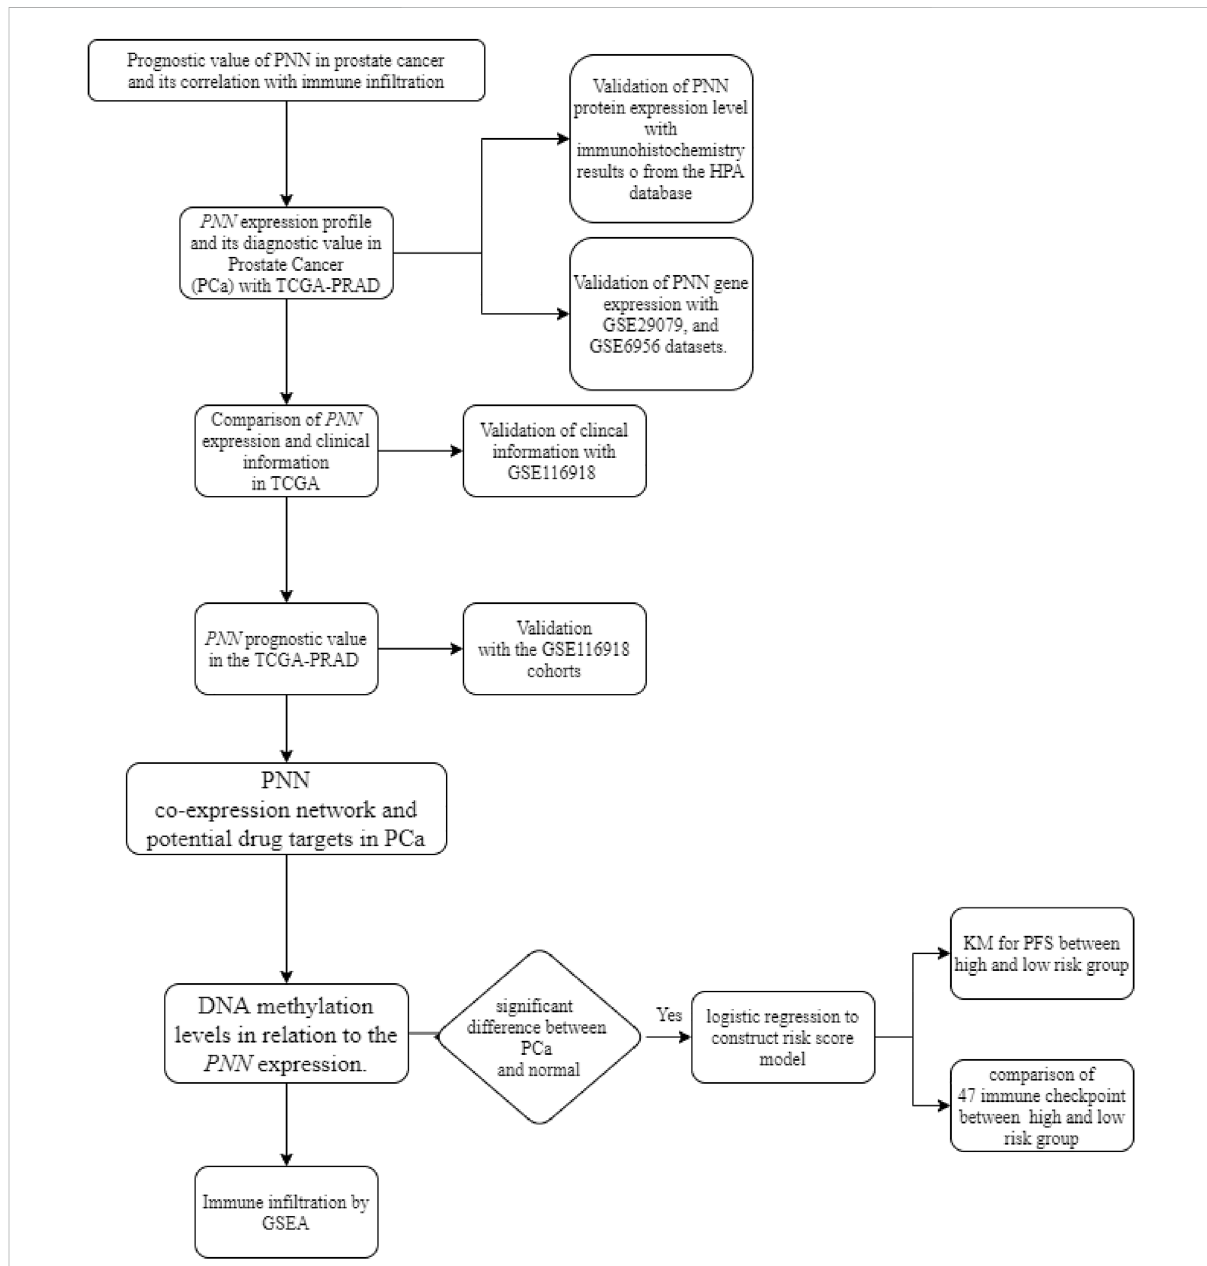
FIGURE 1 Analysis pipeline of PNN performed in this